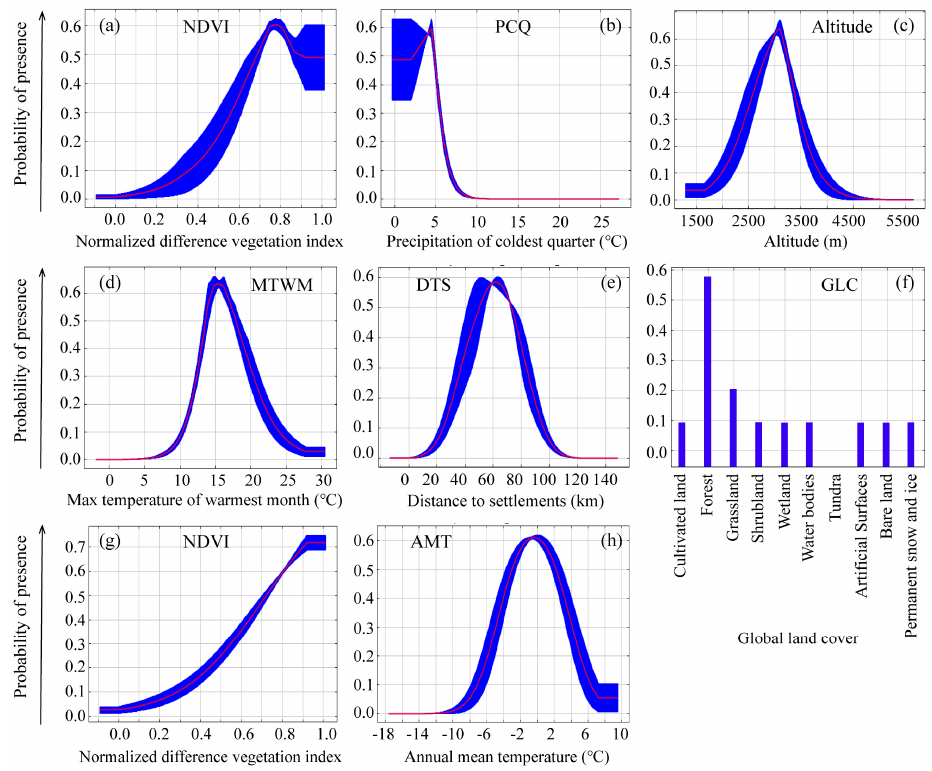
Figure 5. Response curve results of MaxENT modeling of the first four environmental variables for potentially suitable habitat for EP ( a − d ) and BP ( e – h ). These response curves were generated for the most important variables (the top four in each model) and show the mean response of the cross-validated models with 10 replicate runs (red line) and mean ± one standard deviation (blue band).